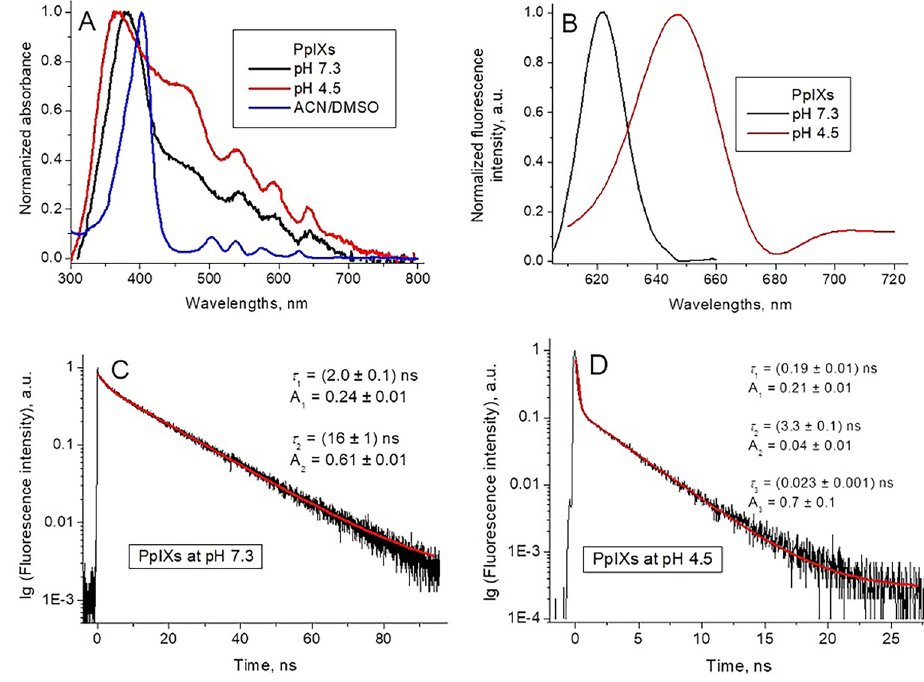
Figure 2. Normalized optical absorption ( A ) and fl uorescence ( l ex=420 nm) ( B ) spectra of synthetic protoporphyrin IX (PpIXs) in different solutions. PpIXs fl uorescence decay kinetic curves and respective fi ttings at pH 7.3 ( C ) and pH 4.5 ( D ) ( l ex=420 nm, l em=628